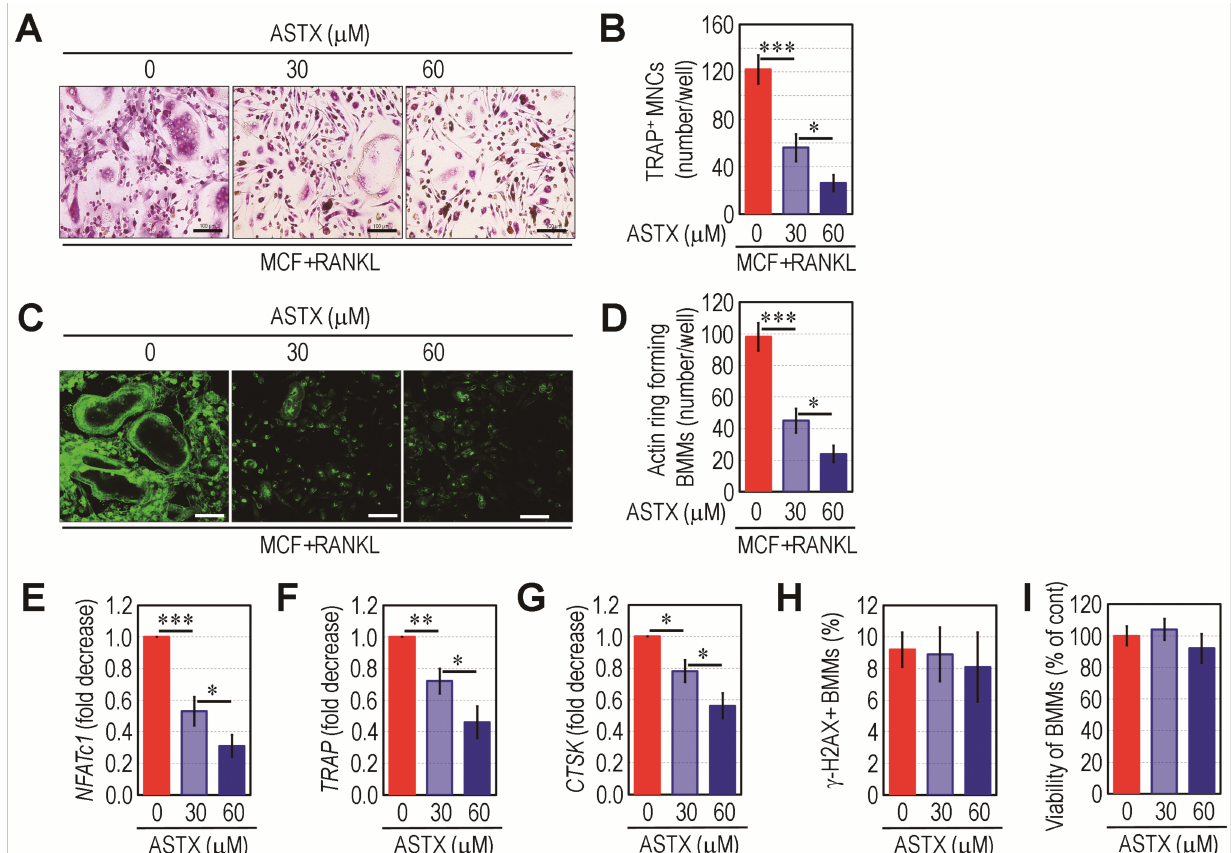
Figure 10. Direct addition of ASTX decreases the formation of osteoclasts and F-actin rings in BMMs in a dose-dependent manner. B6 mice-derived BMMs were incubated in osteoclastogenic medium supplemented with M-CSF and RANKL with or without 30 or 60 µ M ASTX. ( A ) After seven days of incubation, cells were stained with TRAP (Bar = 100 µ m) and ( B ) the number of TRAP + MNCs was calculated under a light microscope. ( C , D ) On the same post-incubation day, the formation of F-actin rings in these cells was observed under a fluorescence microscope (Bar = 100 µ m), and the number of BMMs with actin ring formation was counted. Levels of ( E ) NFATc1 , ( F ) TRAP , and ( G ) CTSK in the cultured BMMs were determined by qRT-PCR two days after incubation. Additionally, BMMs were incubated in growth medium in the presence and absence of the indicated amounts of ASTX for two days. ( H ) Level of γ -H2AX + cells and ( I ) the viability of these cells were determined using a flow cytometer or microplate reader after staining with a DNA damage marker or CCK-8 assay kit. * p < 0.05, ** p < 0.01, and *** p < 0.001 by Scheffe’s multiple range